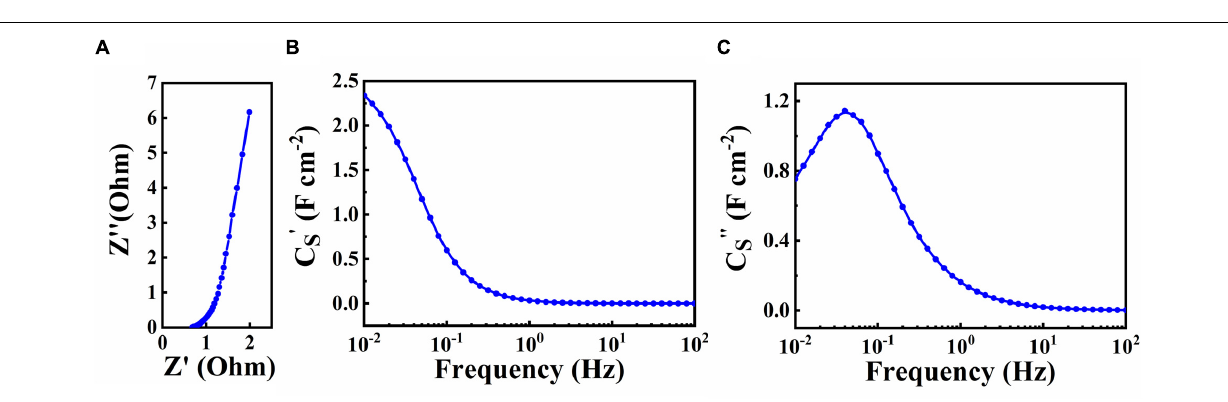
Frontiers in Materials |